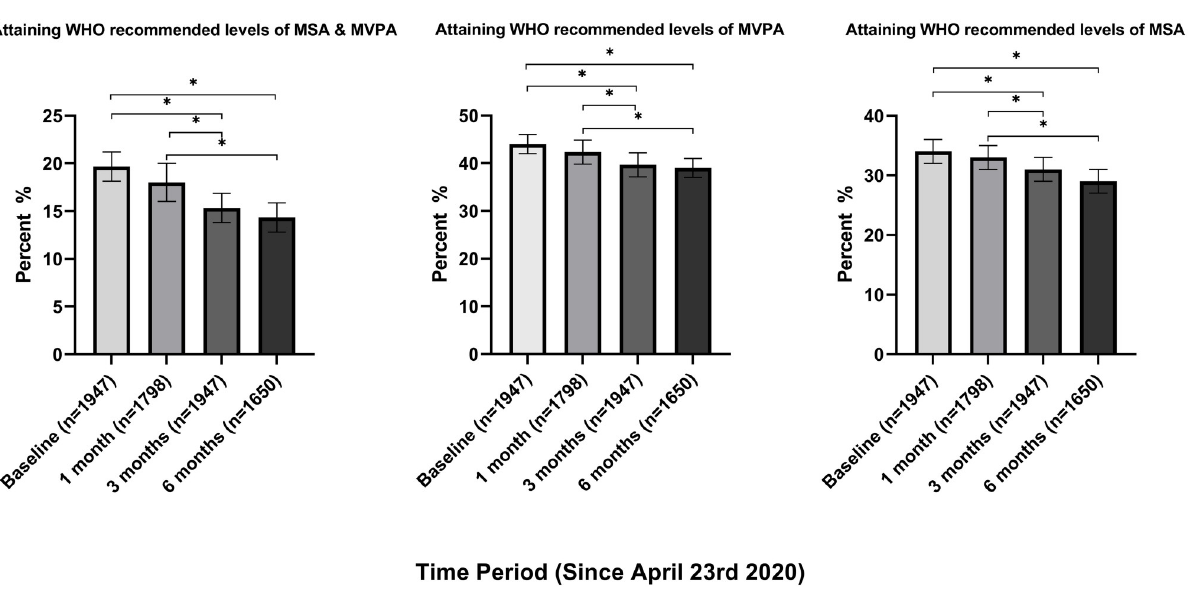
Fig 1. Time trend analysis of PA levels across the COVID-19 pandemic. Time-trends in proportions of participants meeting MVPA, MSA and both WHO PA guidelines & Wald χ 2 pairwise comparison with Sˇida´k correction � p < 0.05.